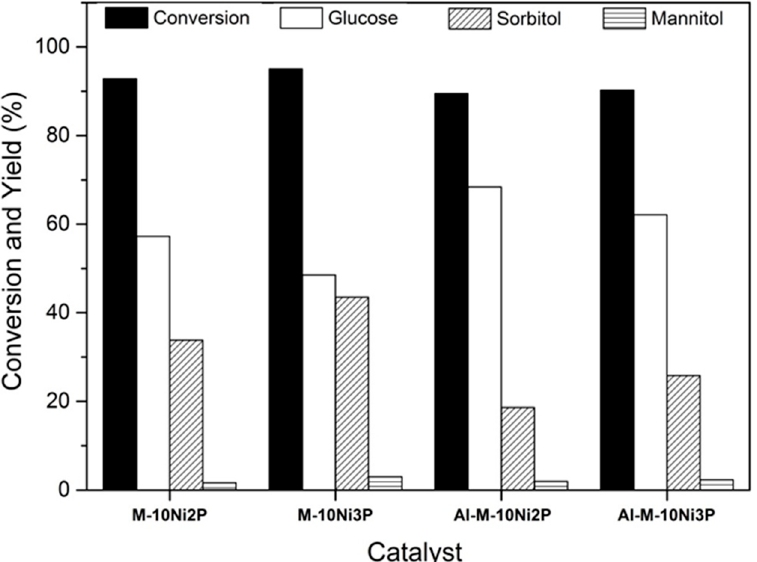
Figure 7. Catalytic performance of M-xNiyP and Al-M-xNiyP catalysts for the hydrolytic hydrogenation of cellobiose at 150 °C, 3 h, 4 MPa of H 2 , 10 mL of 1% cellobiose solution, and 0.08 g of catalyst.